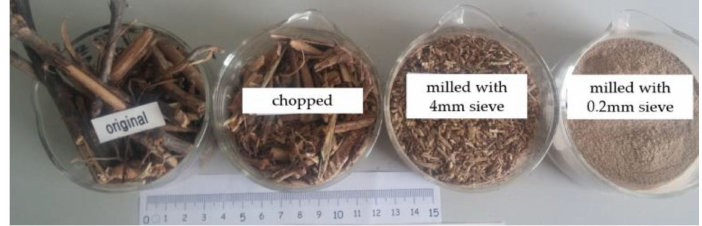
Figure 2. Different size reduction steps of grapevines (scale in